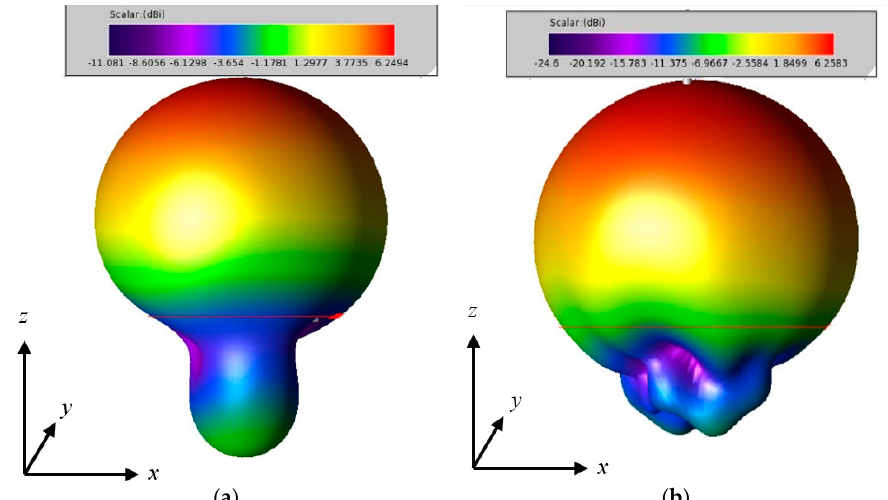
Figure 11. 3D radiation patterns of the P-fed I-shape MSA backed by conductor plate at 2.45 GHz in xz -plane. ( a ) Antenna in the free space; ( b ) antennas on the human body.